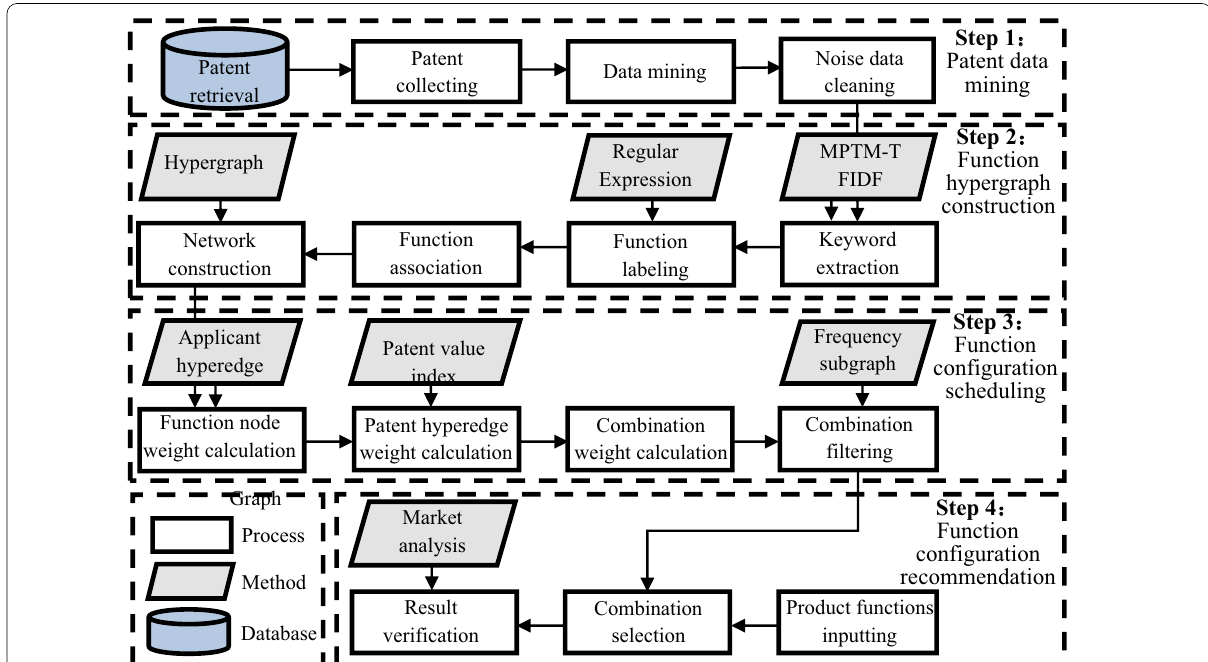
Figure 1 Patent functional configuration framework based on